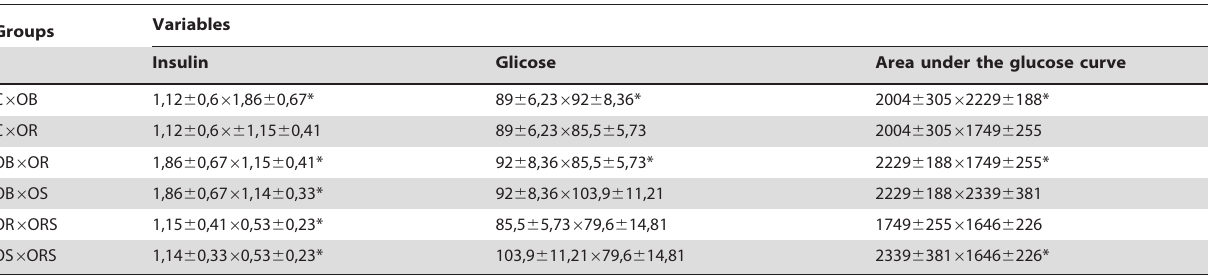
Table 4. Serum insulin, serum glucose and area under the glucose curve.